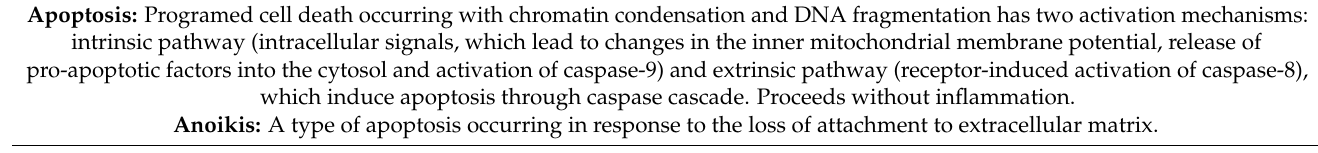
Table 2. Different types of cell death, triggered by different factors and occurring via different molecular mechanisms, with various levels of associated